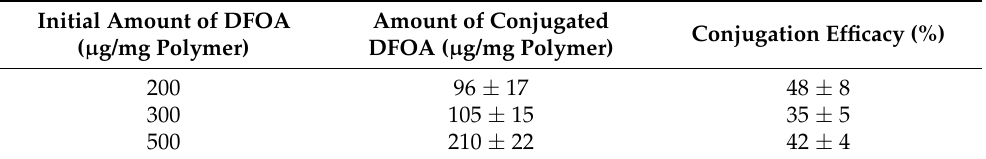
Table 5. Efficacy of DFOA conjugation with P(Glu- co -Phe) depending on the initial amounts of siderophore.